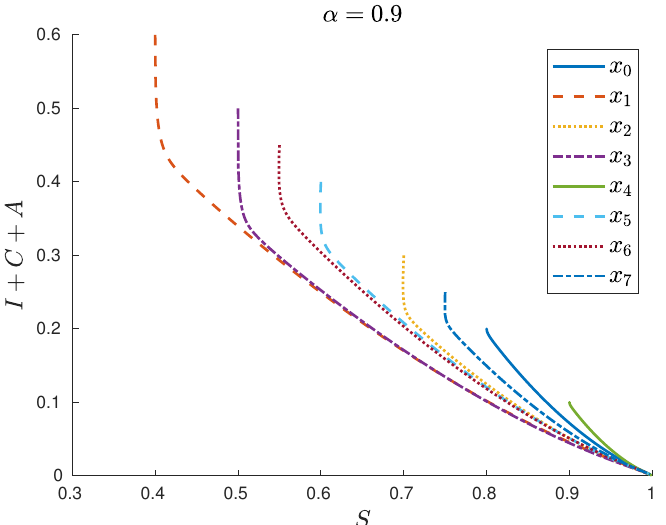
Figure 5. Global stability of the disease free equilibrium Σ 0 = ( 1,0,0, 0 ) , for the fractional model (9), considering α = 0.9 and different initial conditions x i , i = 0, . . . ,7, from (12), on the x -axis S and on the y -axis I + C + A